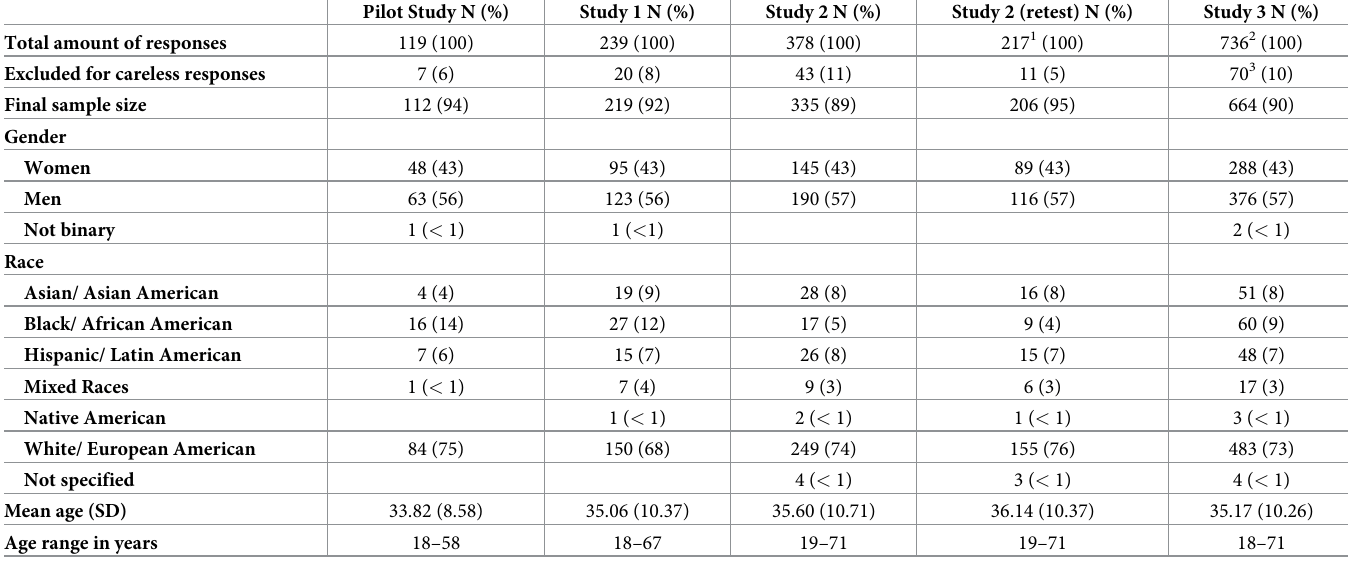
Table 2. Sample characteristics by